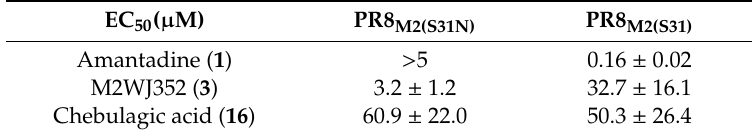
Table 3. E ff ects of amantadine, M2WJ352, and chebulagic acid on viral replication, as measured by plaque reduction assay. Results indicate mean ± s.e.m. from at least 3 independent